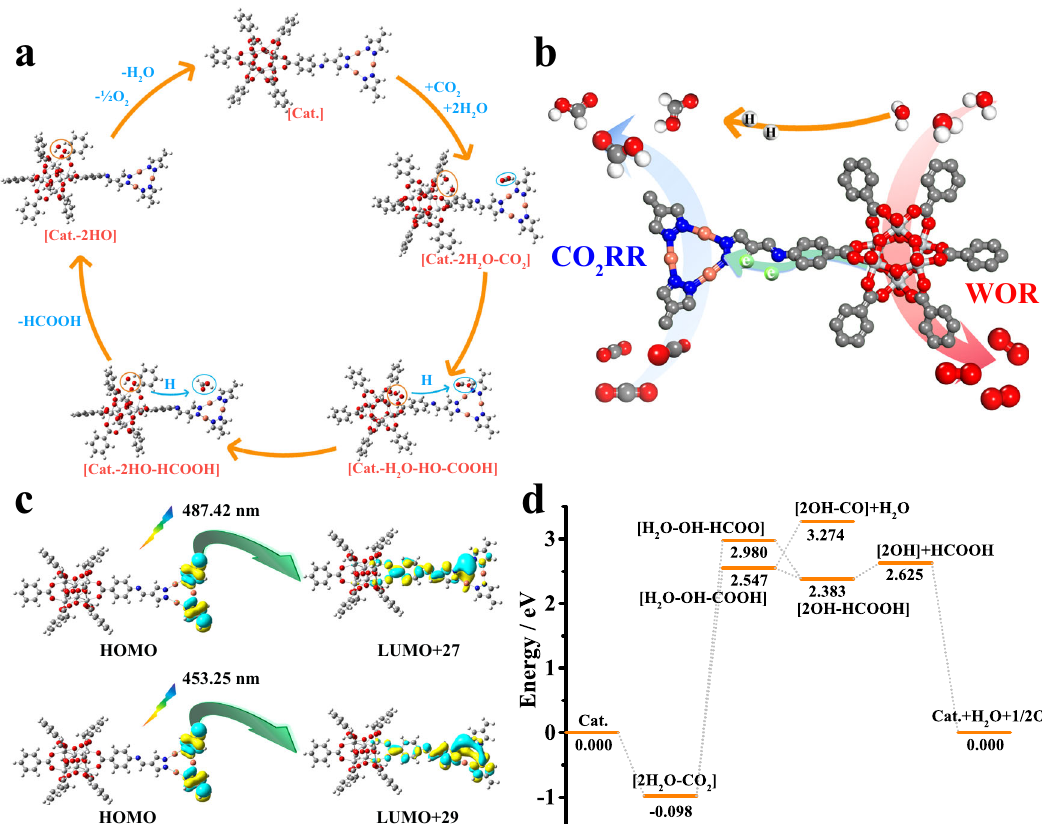
Fig. 5 | Mechanism and DFT calculations. a A proposed reaction pathway for the photocatalytic CO 2 reduction over MCOF-Ti 6 Cu 3 . b Proposed mechanism of CO 2 reduction and H 2 O oxidation. c Transitions of electron cloud distribution under